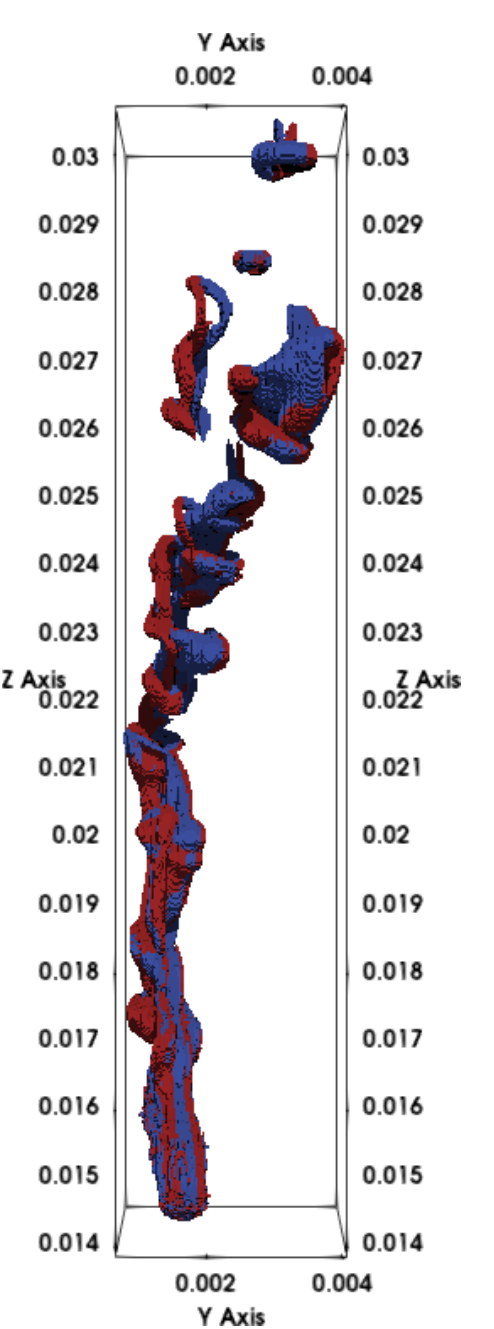
Figure 7. Contours of the stream-wise vorticity for a sphere with Ga = 548.97 at t = 0.19